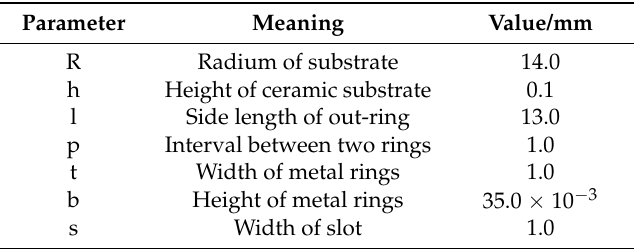
Table 1. Parameters of designed sensor.